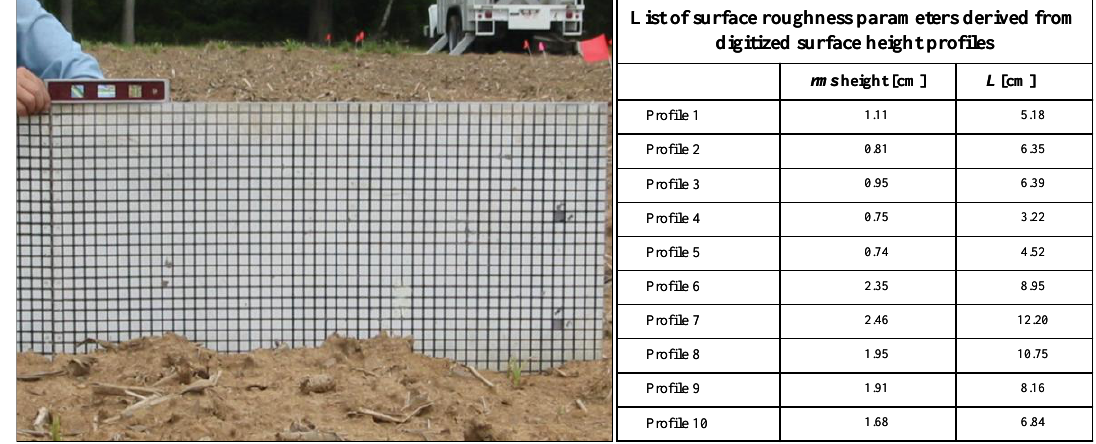
List of surface roughness parameters derived from digitized surface height profiles